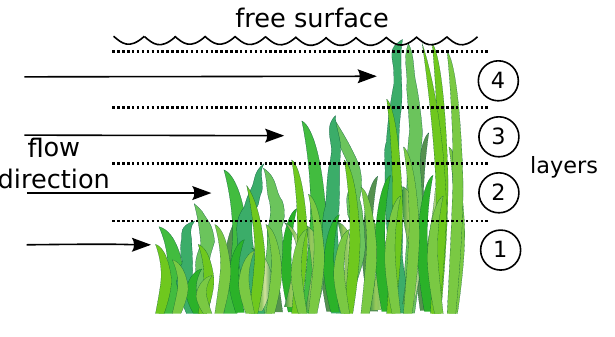
Figure 1. The multi-layer approach in the presence of vegetation. An example showing four layers and different plant heights.